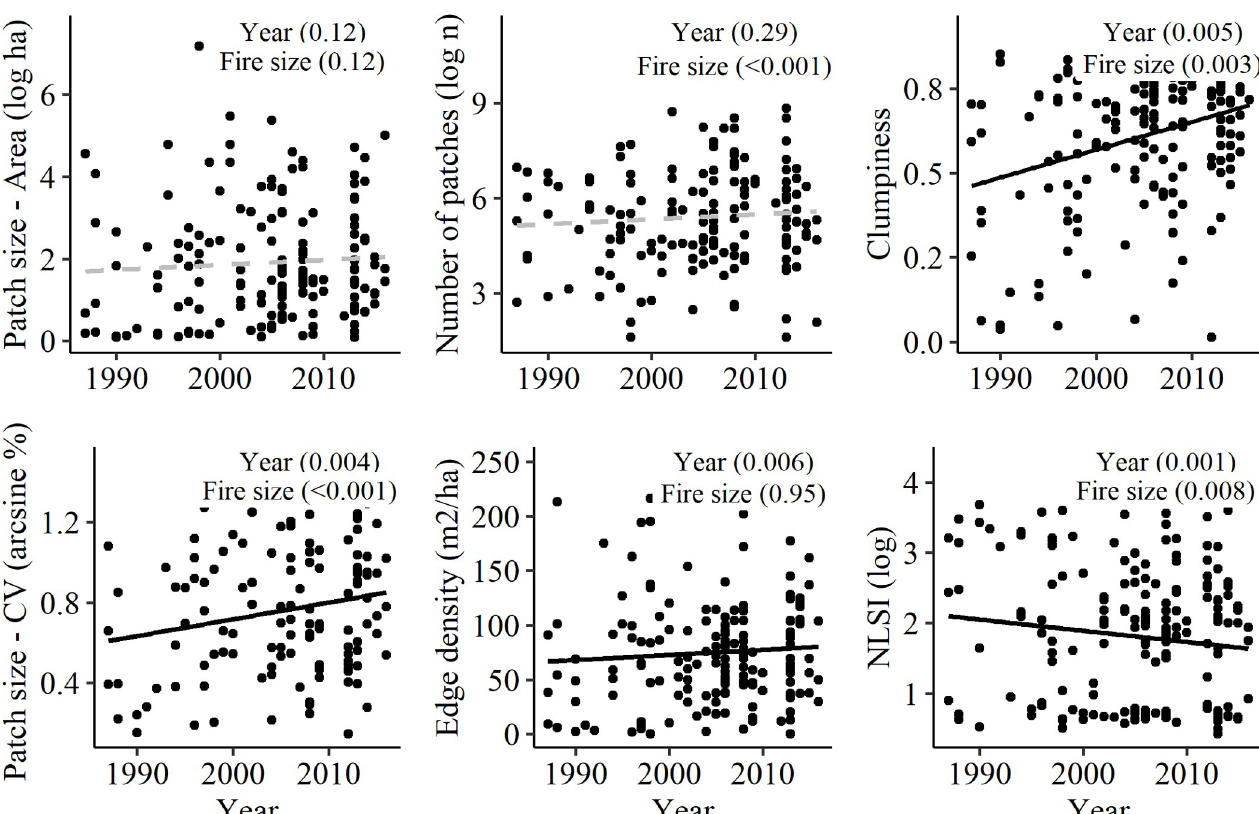
Fig 4. Changes in high-severity spatial metrics over time. Each subplot displays a scatterplot between the Year of the fire and the defined high-severity spatial metric. Dots represent each of the 162 wildfires. Values are the results for single mixed effects models where Year and Fire size are fixed effects and Bioregion is a random effect. Lines represent significant (solid black) or not significant (dashed grey) linear